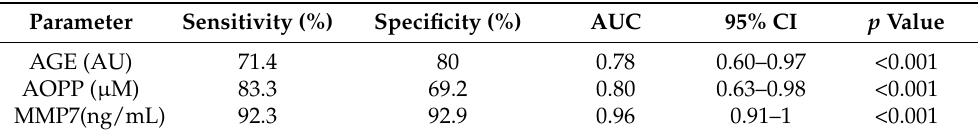
Table 2. ROC curves analysis to distinguish IPF from healthy participants. AGE: Advanced gly- Table 3. ROC curves analysis to distinguish CTD-ILD from healthy participants. AGE: Advanced teinase 7. AUC: Area under the curve. glycosylated end products. AOPP: Advanced oxidation protein products. MMP7: Matrix metallopro- teinase 7. AUC: Area under the